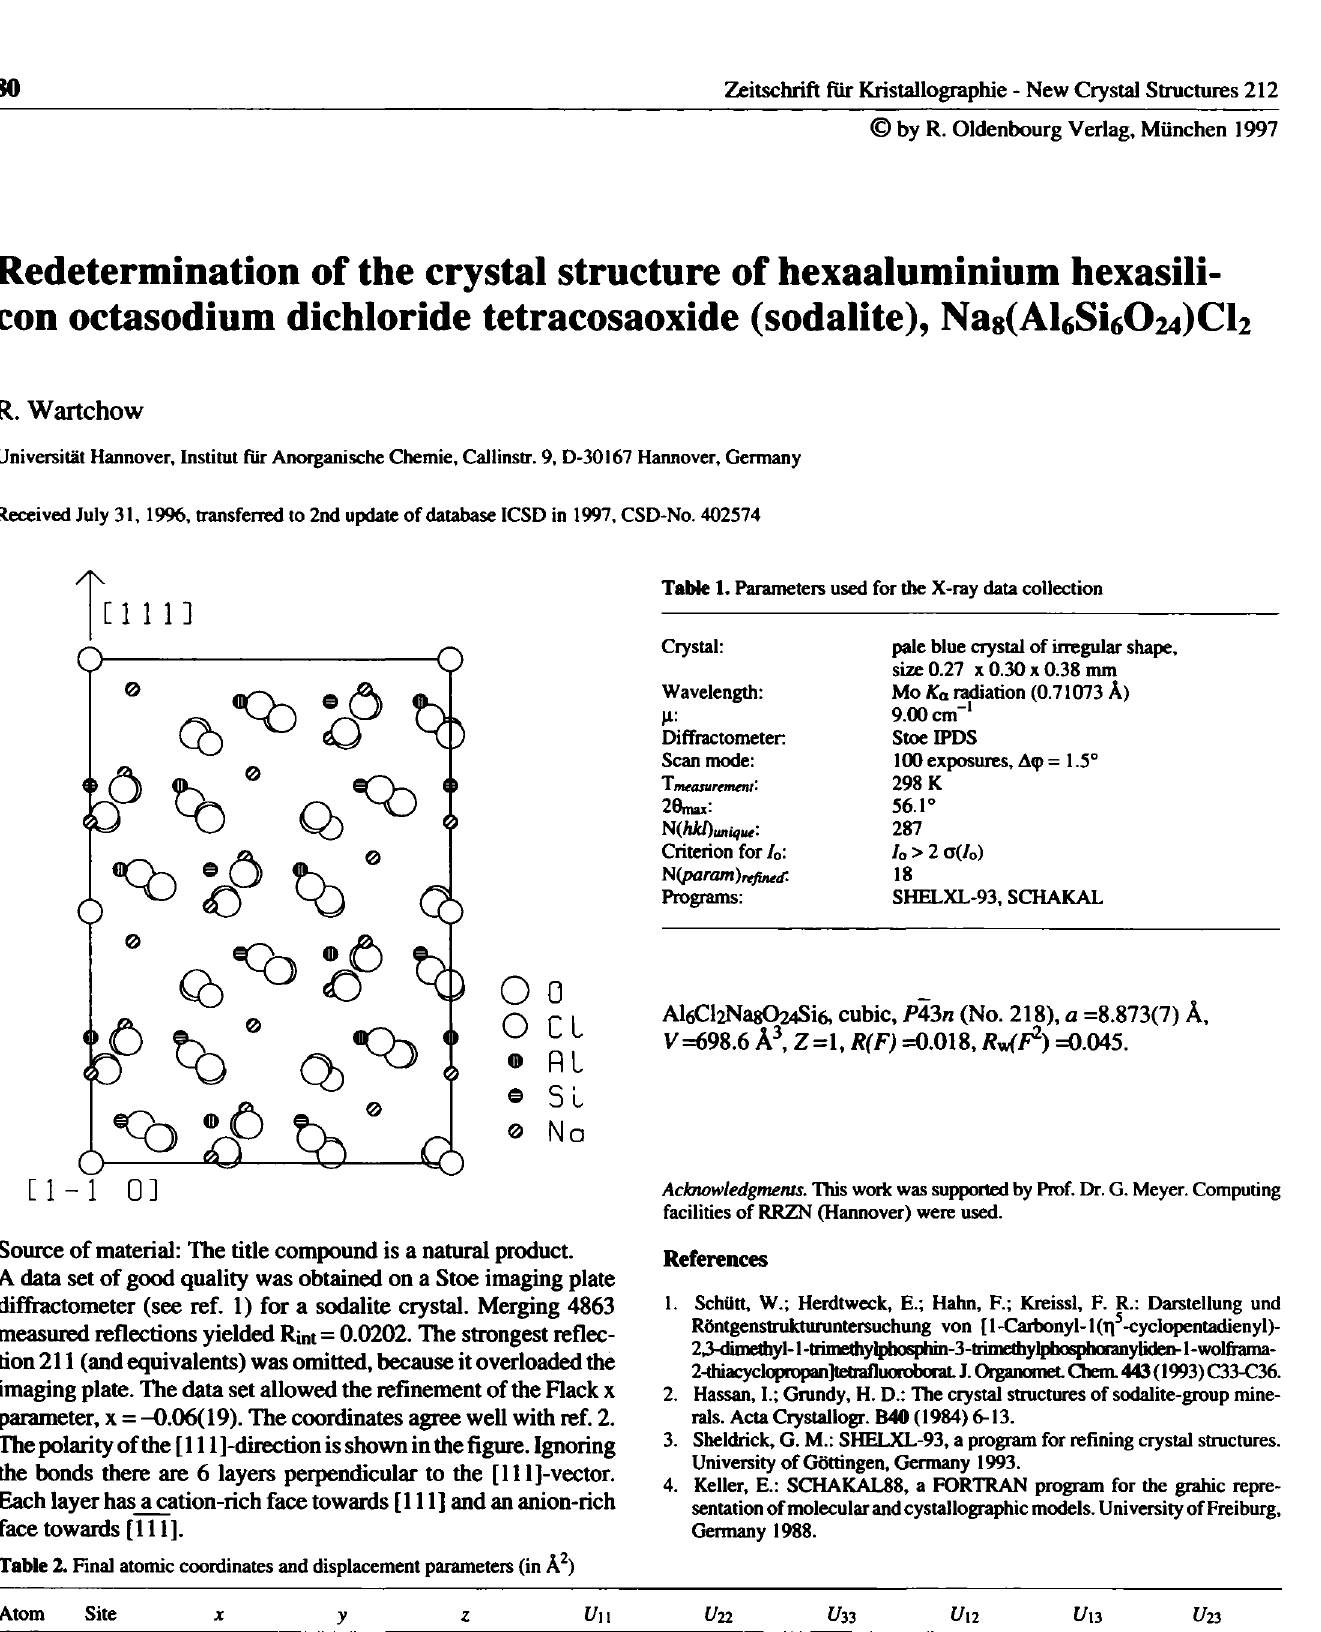
Table 2. Final atomic coordinates and displacement parameters (in Â 2